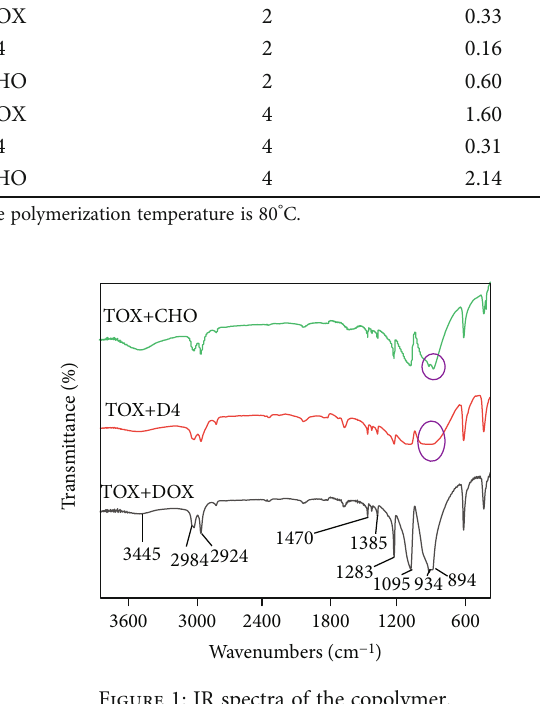
Figure 1: IR spectra of the copolymer.